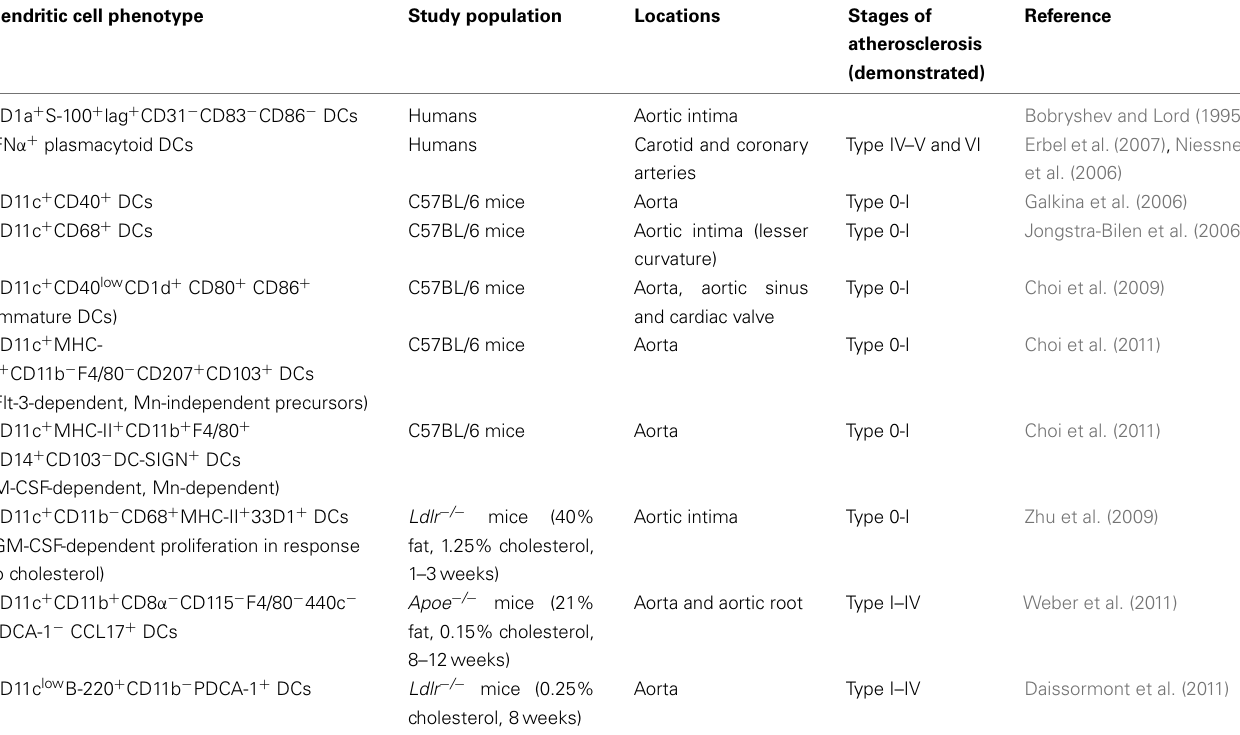
Table 1 | Location and DC phenotype in healthy and atherosclerotic aortas. Dendritic cell